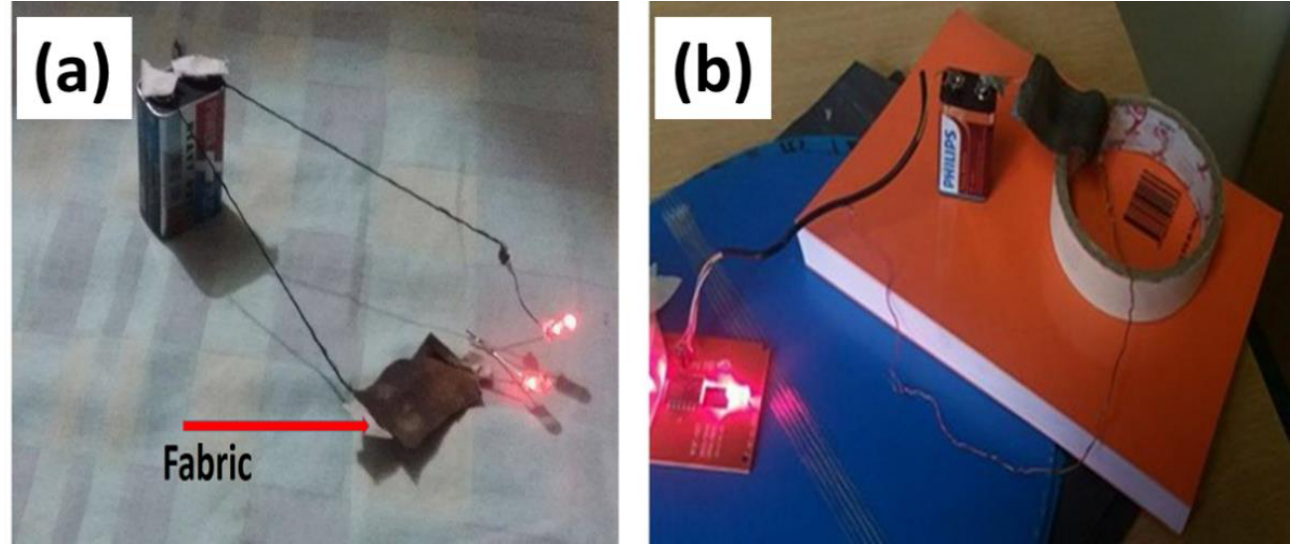
Figure 3. Flow of electricity through ( a ) silver particles ( b ) copper particle-coated fabrics .